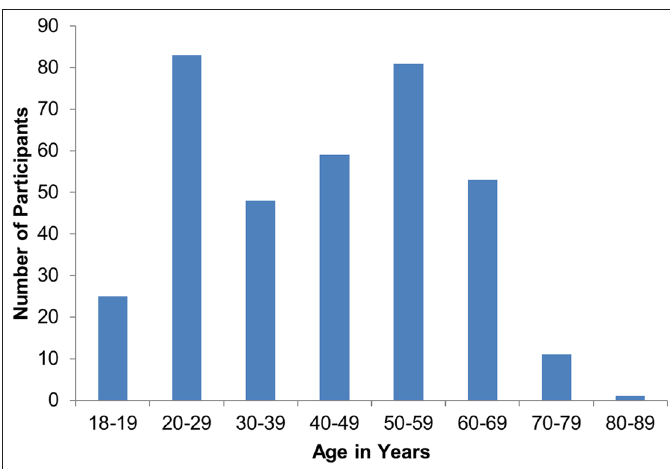
Figure 1: Age of participants. N = 361.